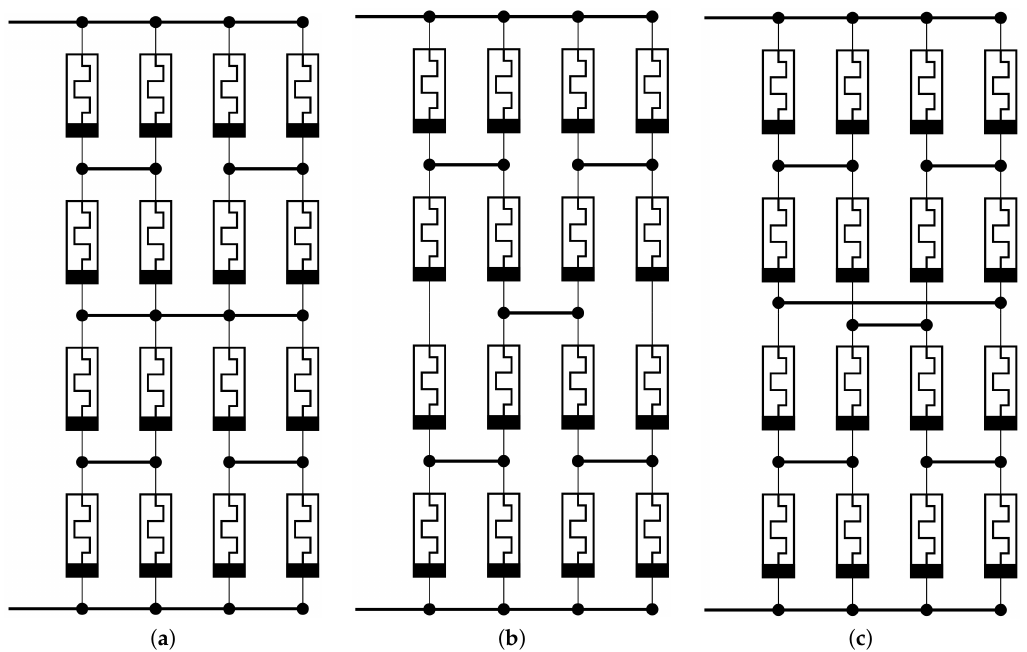
Figure 2. Measured general circuits. ( a ) H-fractal type of array. ( b ) Checkerboard type of array. ( c ) Our newly introduced